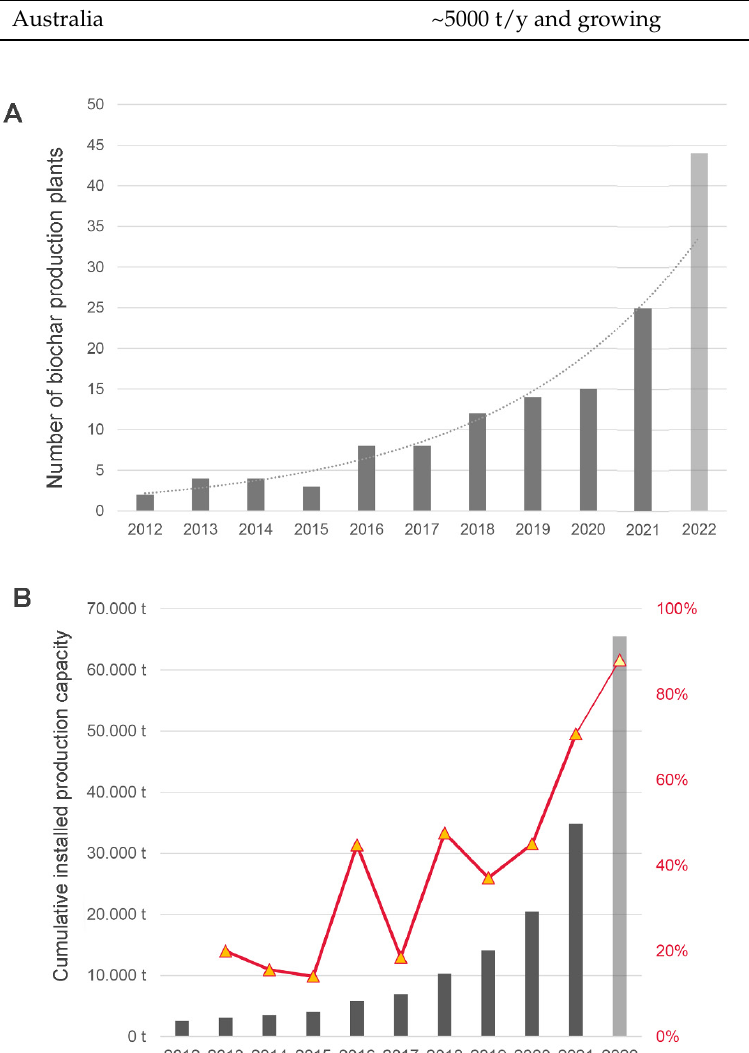
Figure 1. Current state of the European biochar market. ( A ) number of biochar production plants installed per year; ( B ) cumulative biochar production capacity (bars, expressed in t, left y axis) and growth rate (red line, expressed in %, right y axis) [77].